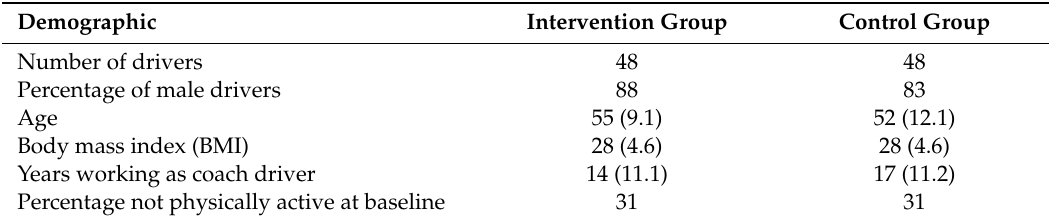
Table 1. Population demographics (mean and standard deviation) for the intervention and control groups.